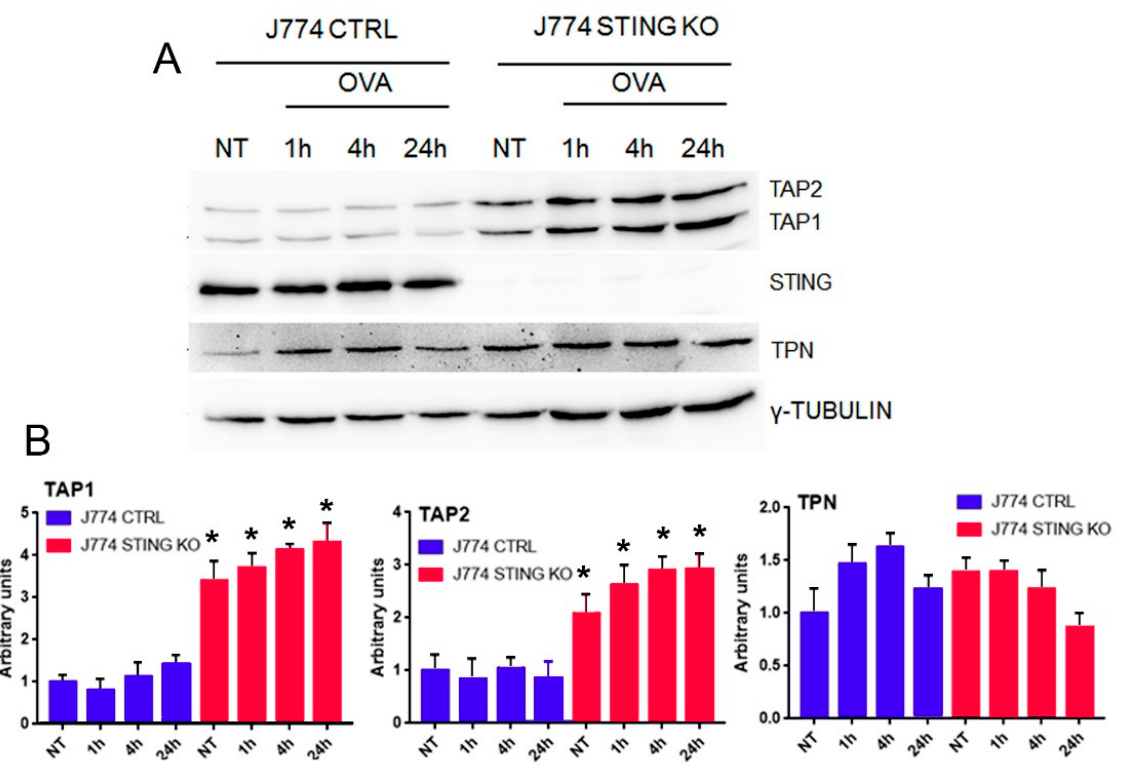
Figure 4. Protein expression of the components of the peptide-loading complex (TAP1, TAP2 and TPN) in control and STING KO macrophages. ( A ) J774 CTRL and STING KO cells (5 × 10 6 ) were treated with 500 µ g/mL of OVA or left untreated for the indicated time. Whole cell extracts (30 µ g) were analyzed by western blot using the indicated antibodies. γ -Tubulin was included as a control for protein loading. ( B ) Quantifications of the protein levels of TAP1, TAP2 and TPN in CTRL (blue bars) and STING KO (red bars) were calculated by ImageJ software as fold-change relative to unstimulated, which was set to 1.0. Values (mean ± SE, n = 4) are shown. The asterisks indicate a statistically significant difference compared to the untreated control, according to a Student’s t -test ( p < 0.01). 2.3. STING Is Required for an Efficient Expression of β 2-Microglobulin and for the Formation